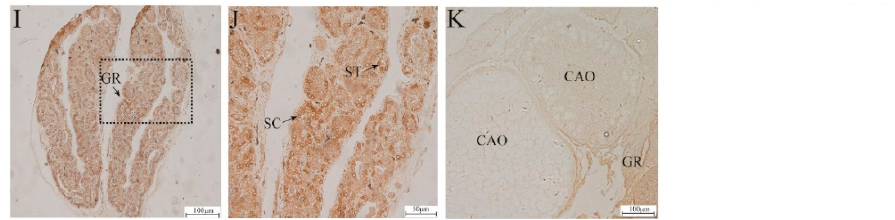
Figure 4. Immunohistochemical staining of cyt-c in the gonad tissues of Monopterus albus at different stages of development. ( A , B ), ovary; ( C , D ), early intersexual stage gonad; ( E , F ), middle intersexual stage gonad; ( G , H ), late intersexual stage gonad; ( I , J ), testis; ( K ), negative control. CAO, cortical alveoli oocyte; PGO, primary growth stage; YO, yolk oocytes; GC, granulosa cell; GR, gonadal ridge; SC, spermatocyte; ST, spermatid.